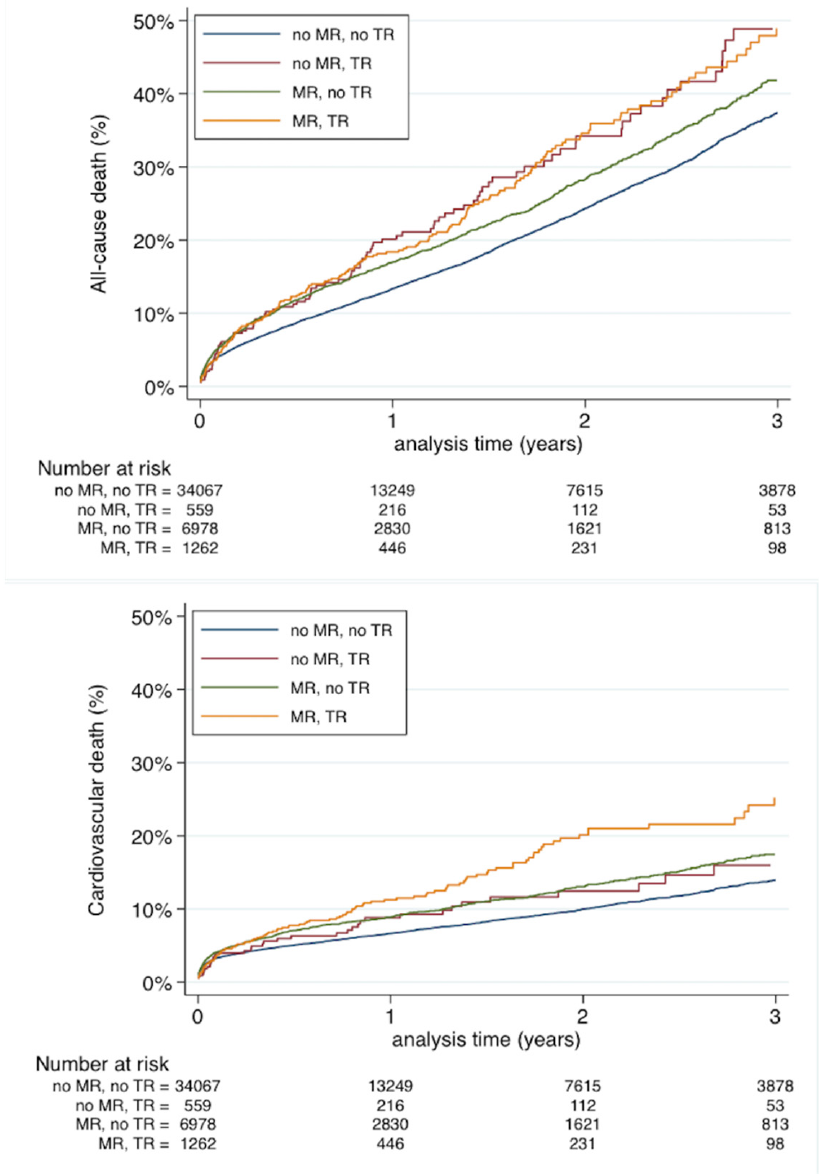
Figure 3. Cumulative incidences for all-cause mortality (top panel) and cardiovascular death (lower panel) of patients treated with TAVI according to MR (or no MR) and TR (or no TR) at baseline. On multivariable Cox regression analysis, neither baseline MR (adjusted HR: 1.010, 95%CI: 0.951–1.072, p = 0.75) nor TR (adjusted HR: 1.076, 95%CI: 0.960–1.206, p = 0.21) was an independent risk predictor for all-cause mortality in TAVI patients (Table 2). Neither baseline MR (adjusted HR: 1.062, 95%CI: 0.973–1.159, p = 0.18) nor TR (adjusted HR: 1.119, 95%CI: 0.953–1.316, p = 0.17) was an independent risk predictor for cardiovascular mortality in TAVI patients (Table 3). Baseline MR (adjusted HR: 1.132, 95%CI: 1.071–1.196, p < 0.0001), rather than baseline TR (adjusted HR: 1.100, 95%CI: 0.994–1.218, p = 0.07), was independently associated with rehospitalization for HF in TAVI patients (Table